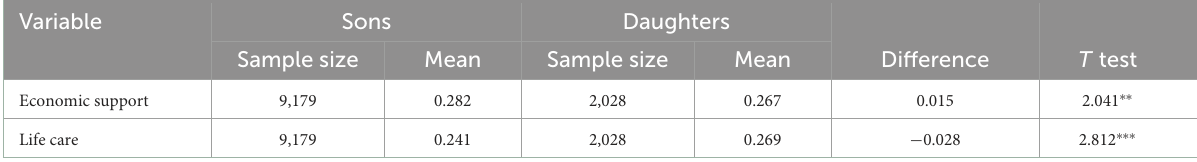
TABLE 2 Descriptive statistics of children’s characteristics. Variable